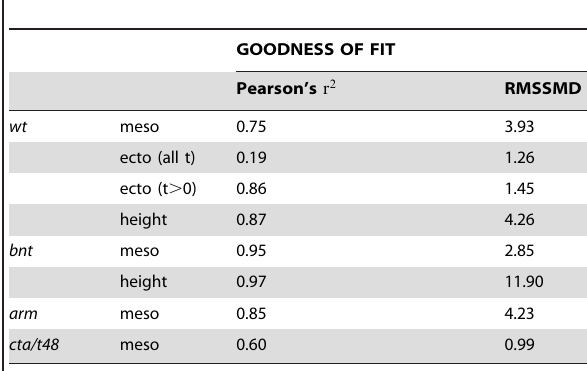
Table 1. Goodness-of-fit analysis for in silico versus in vivo